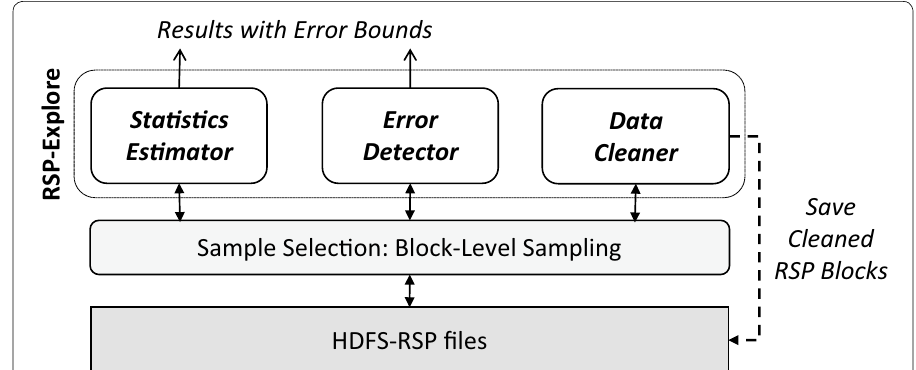
Fig. 1 RSP-Explore. Block-level samples of RSP blocks are used for statistical estimation, error detection and data